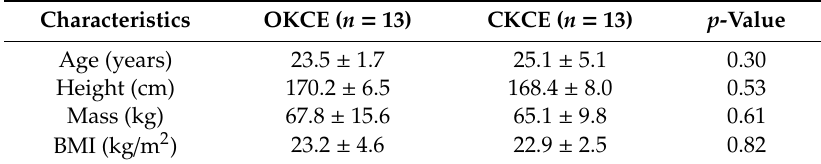
Table 1. General characteristics of the study